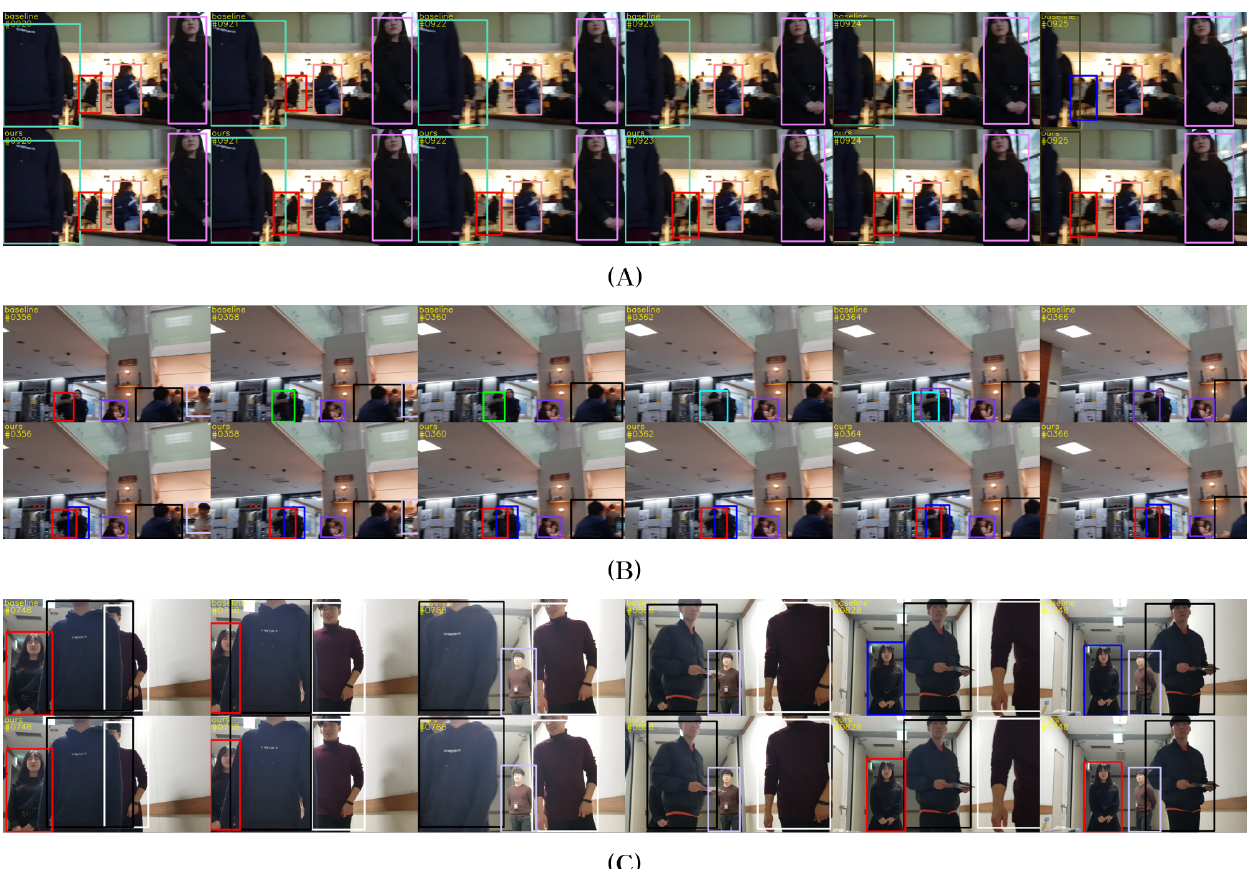
Figure 15. Qualitative examples of our finalized model with all three proposed methods based on the DeepSORT baseline. ( A ), ( B ), and ( C ) denote the experimental results in the Patrol, Interaction-1, and Interaction-2 datasets,